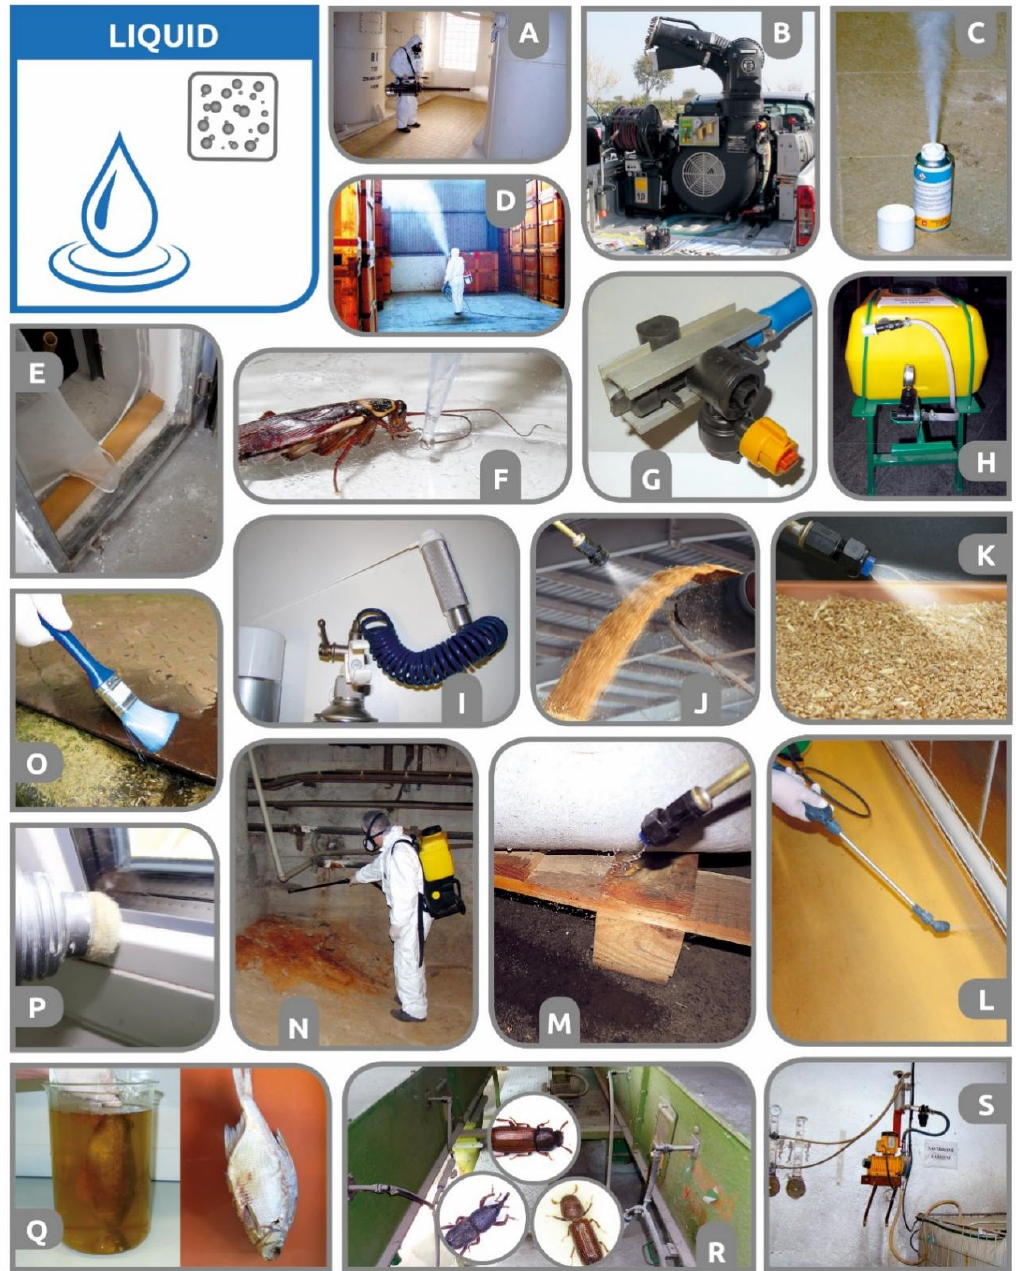
Figure 3. Liquids ( A ) Portable aerosol thermal fogging in food industry silos; ( B ) vehicle-carried cold aerosol applicator; ( C ) cold aerosol container pressurized with propellant; ( D ) cold ULV aerosol application in a store; ( E ) barrier treatment— fluid insecticide-soaked sponge door mat; ( F ) baits—fluid carrier with attractant toxicant or genetic disruptor (dsRNA encapsulated with liposome carriers); ( G ) spray nozzle with device for its attachment to grain conveyor belts; ( H ) mobile compressor and sprayer for grain protectant application; ( I ) dual injection spray/aerosol device; ( J ) visualization of spray protectant applied on grain moving on a conveyer belt ; ( K ) visualization of spray/aerosol protectant application on falling grain; ( L ) band barrier or spot spray treatment; ( M ) spray barrier treatment of transport pallets; ( N ) broadcast spray of walls; ( O ) insecticide brushing; ( P ) insecticide sponging; ( Q ) dip application of insecticide protectant on the surface of dried fish; ( R ) multipoint treatment of grain moving on covered conveyer belts (piping is visible; spray nozzles hidden inside covered equipment); ( S ) wall-mounted compressor, insecticide tank, and piping for grain treatment located at the bottom of a grain silo (photographs A–S: V. Stejskal; R. Aulicky, T. Vendl).